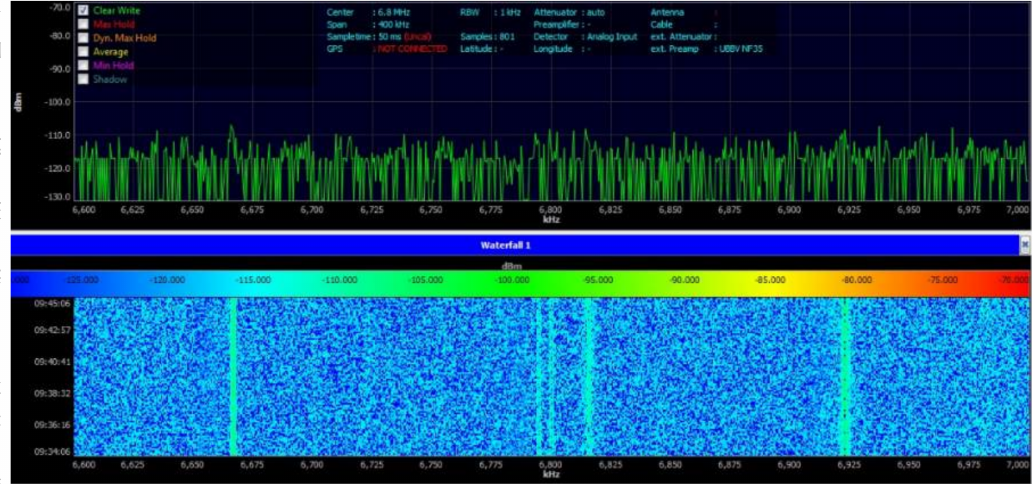
Figure A2. Measured noise level—Gulf of Guinea, 24 November